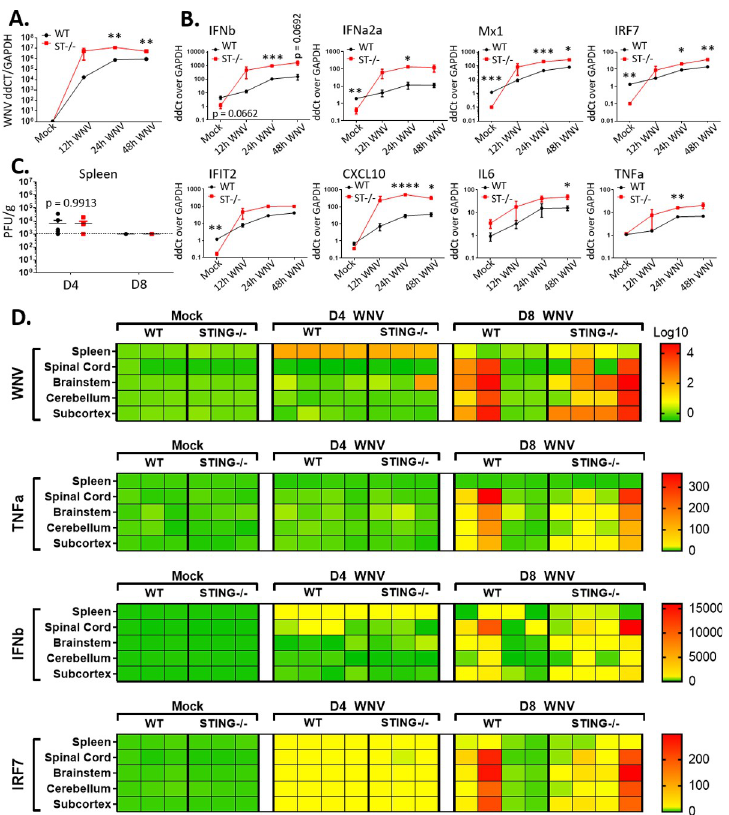
Fig 3. STING deficiency leads to increased innate immune signaling during WNV infection. (A-B) (A) WNV detection in BMDM by RT-qPCR, (B) innate immune response gene expression in WNV-infected BMDM over an infection time course. Bone marrow was harvested and differentiated into BMDM with mMCSF for 7 days. Cells were infected and harvested at the indicated time-points. Mock infected cells harvested at 12hpi. n = 3 infectious replicates. Results were reproducibly significant in multiple studies. Calculated as linear fold change over WT Mock. Unpaired students t-test; p = 0.05 � ; p = 0.005 �� , p = 0.0005 ��� . (C) Splenic WNV titers at D4 and D8 post infection (PFU/g detected by plaque assay). n = 3–4. Graphed as stacking points. Limit of detection indicated by dashed line. Unpaired students t-test; p = 0.05 � . (D) In vivo innate immune profile in splenic and CNS tissues. RT-qPCR detection of innate immune genes in the spleen, spinal cord and brain regions (brain stem, cerebellum, sub-cortex). Columns indicate individual mice; rows the different tissues. Calculated as log (WNV) or linear (immune) fold change over GAPDH in WT Mock. Dark red indicates values outside of (above) set